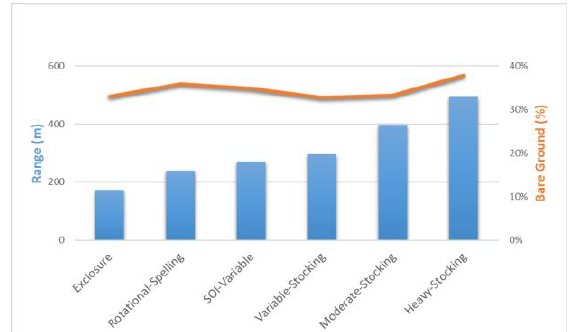
Figure 8. Mean bare ground (line) and spatial range